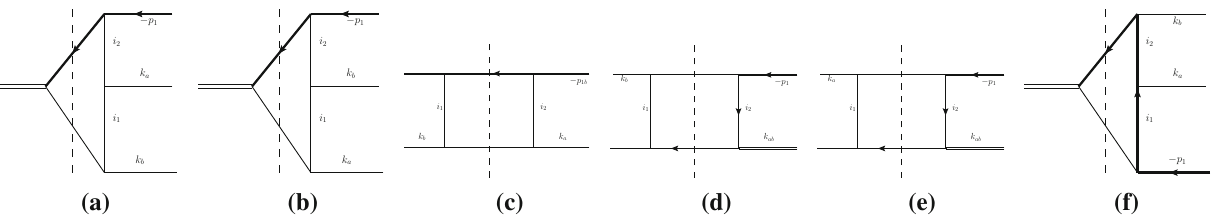
Fig. 4 Master integrals for real correction. i 1 , 2 = 0 , 1 are the indices of propagators. k ab = k a + k b , p 1 a = p 1 − k a , p 1 b = p 1 − k b . External momenta on left-hand side of the cut are ingoing and those on right-